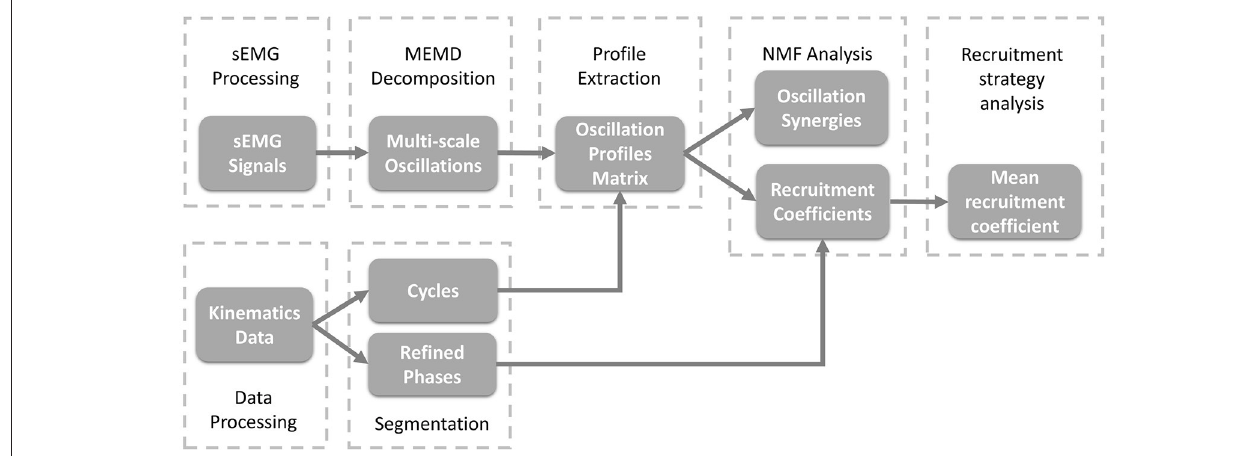
FIGURE 2 | Block diagram of the proposed oscillation synergy analysis framework.